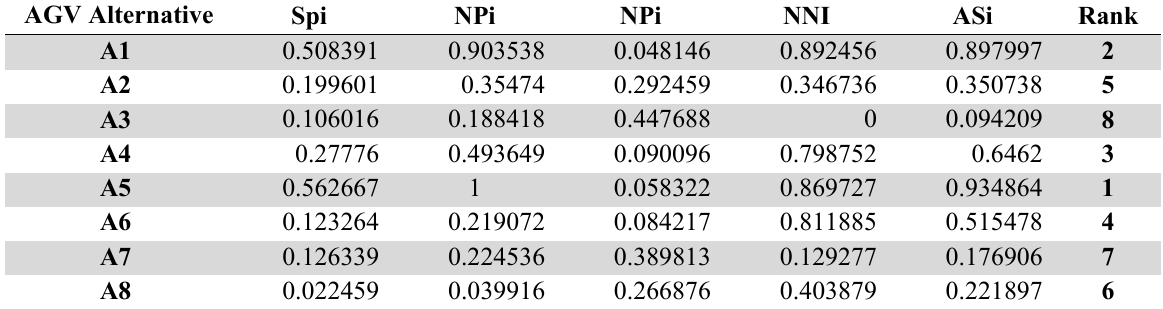
Appraisal score obtained from normalised weighted sum of positive and negative distance from average AGV Alternative Spi NPi NPi NNI ASi